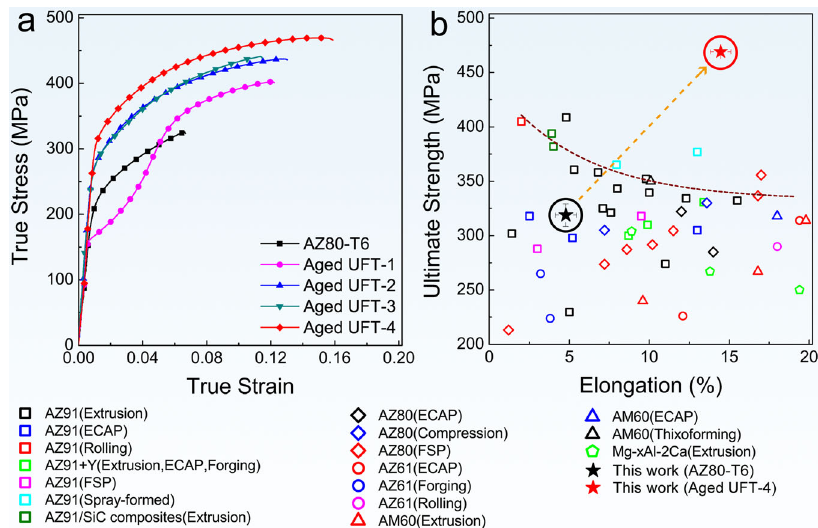
Fig. 5 Tensile mechanical properties at room temperature. a Stress-strain curves under tension along the transverse direction (TD). b Comparison of the ultimate tensile strengths and uniform elongations between the aged UFT-4 and typical precipitate-hardened Mg – Al alloys subjected to different thermomechanical processes (AZ91 after Extrusion 27,28 , ECAP 27 , Rolling 29 , FSP 30 , Spray formed 31 . AZ91 + Y after Extrusion 32 , ECAP 33 , Forging; 33 AZ91/SiC composites after Extrusion; 34 AZ80 after ECAP 35 , Compression 36 , FSP; 37,38 AZ61 after ECAP 39 , Forging 40 , Rolling; 41 AM60 after Extrusion 42,43 , ECAP 44 , Thixoforming 45 . Mg-xAl-2Ca after Extrusion 46 ). Error bars in a and b represent one standard deviation of the data from the mean. ECAP refers to equal channel angular process and FSP denotes friction stir